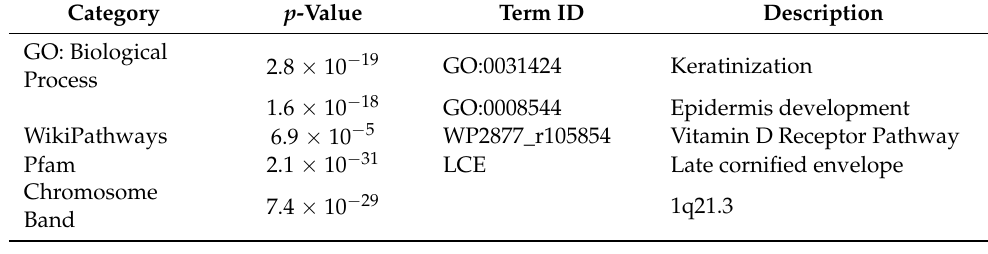
Figure 8. HGCA2.0 C1orf68 5 internal node coexpression clade.